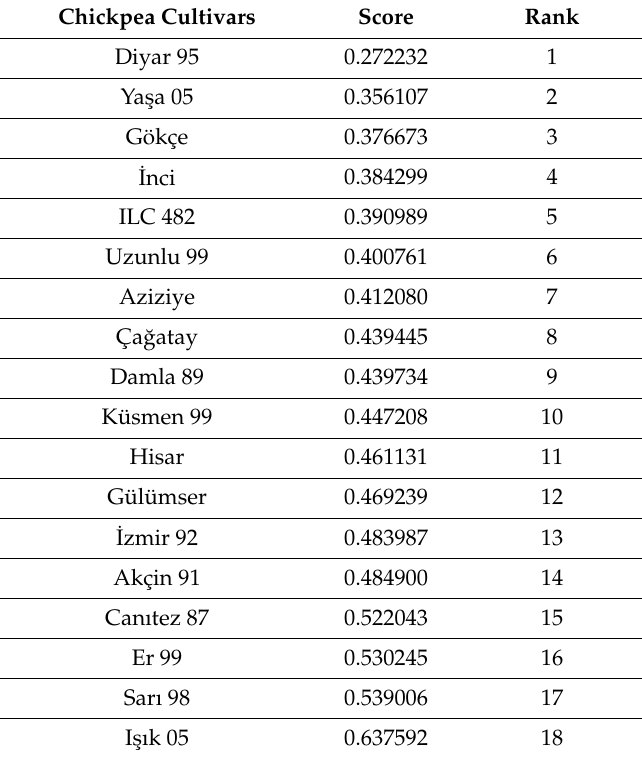
Table 14. Rank of chickpea